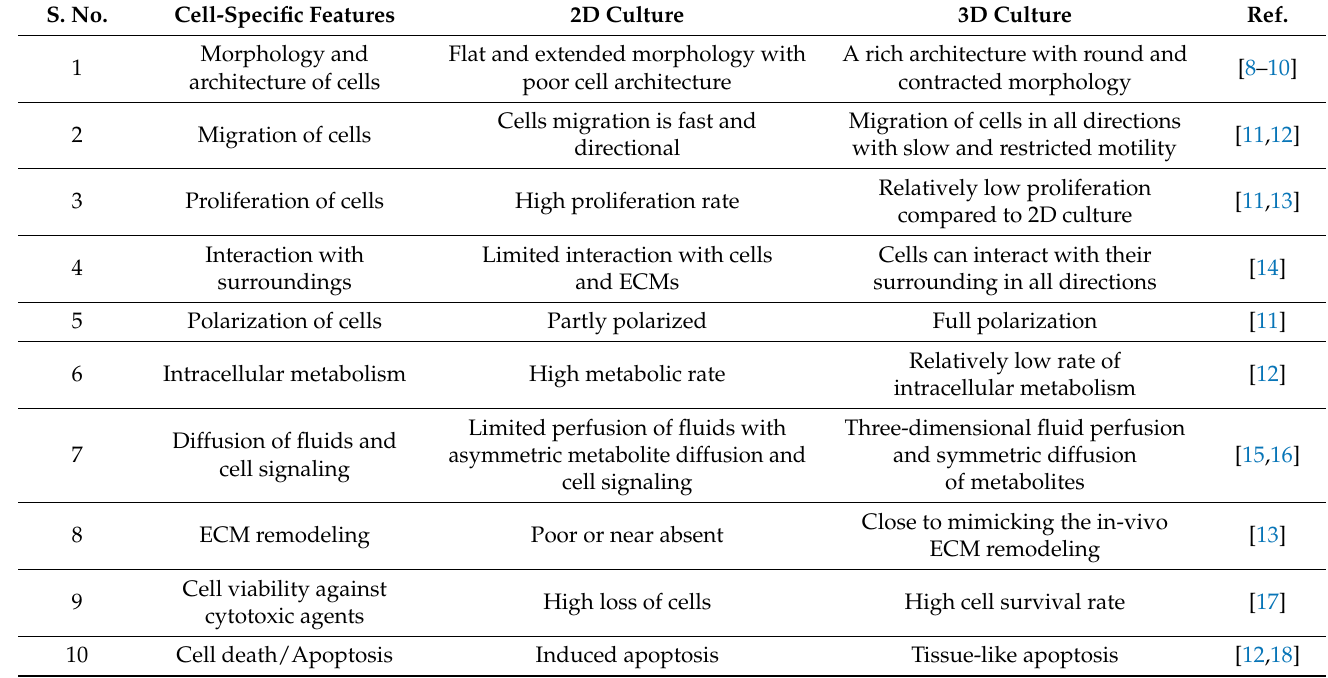
Table 1. Comparison of cell behavior under 2D and 3D culture